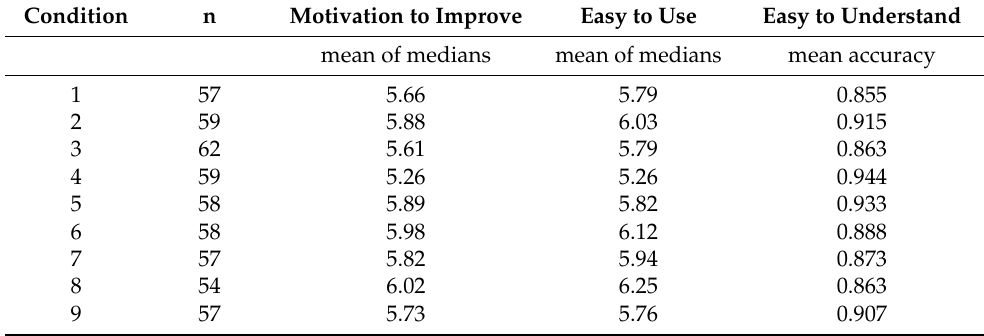
Table 3. Condition performance.